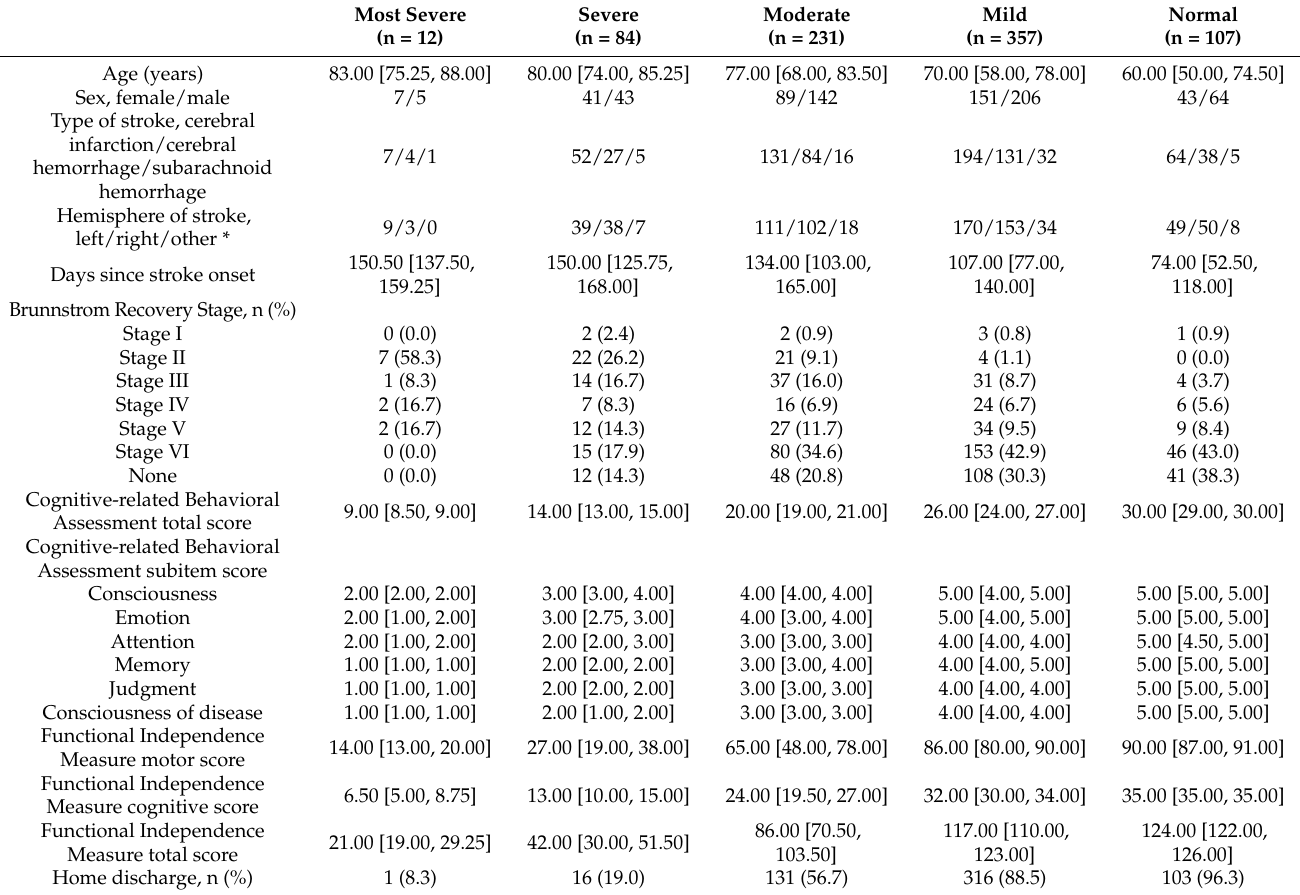
Table 2. Patient characteristics by CBA